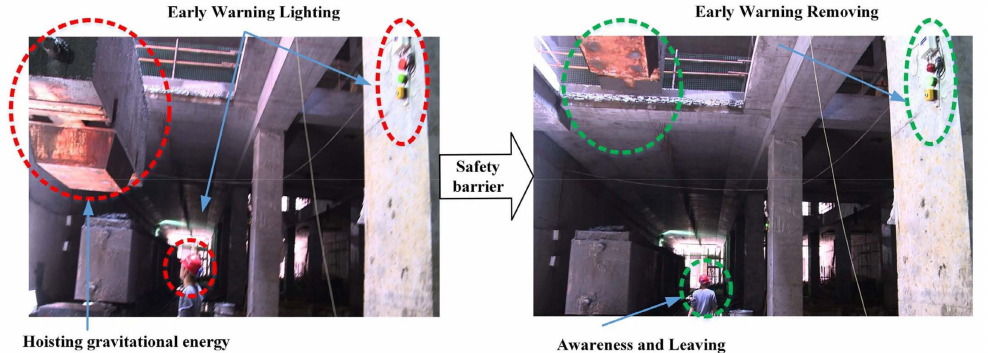
Figure 8. Hazard energy monitoring and safety barrier response in the tunnel shaft area